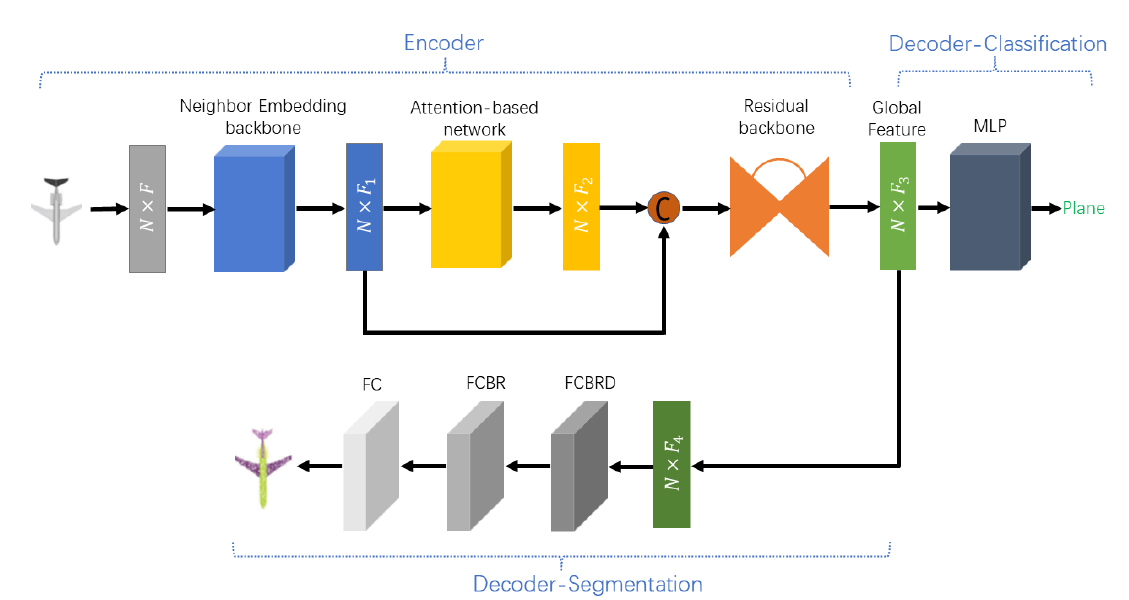
Figure 1. The architecture of TR-Net. The decoder of TR-Net consists of classification (top branch) and segmentation (bottom branch). C means concatenate operator. FCBR consists of fully connected layer, batch normalization and ReLU. FCBRD stands FCBR followed by a Dropout layer with rate